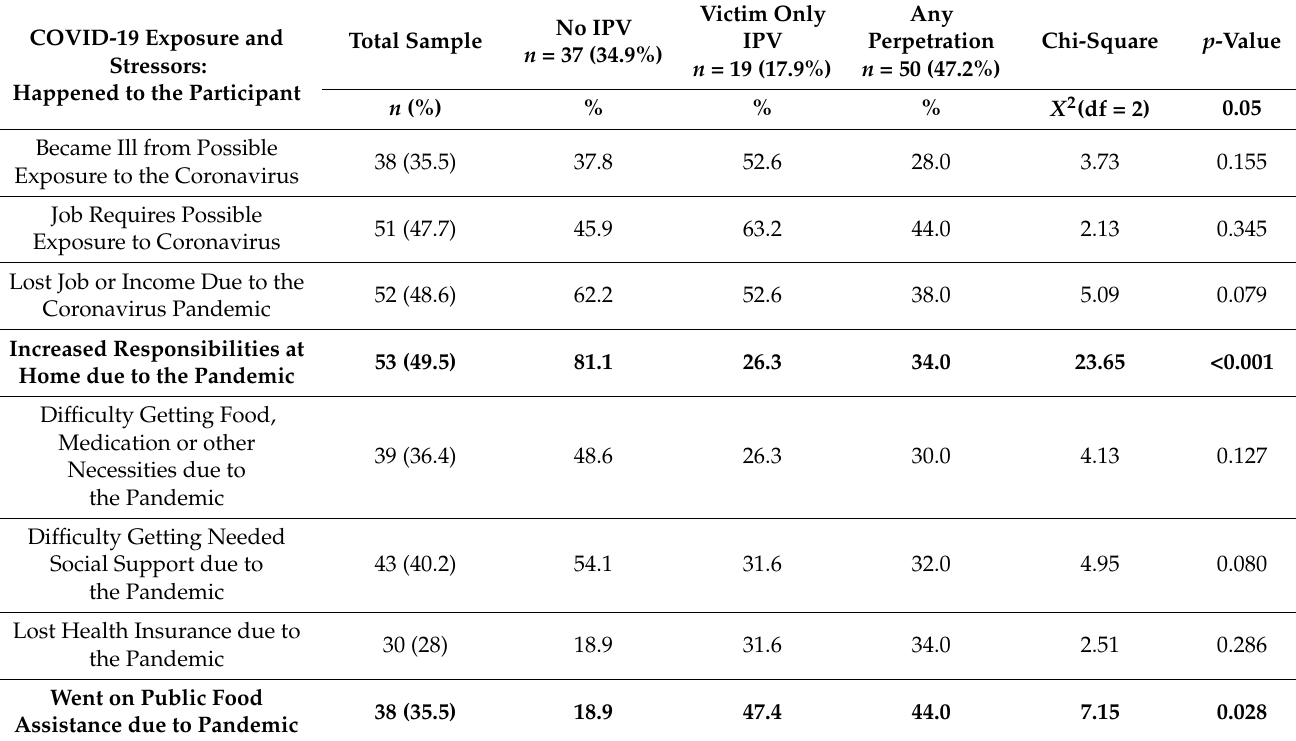
Table 4. Chi-square analyses of the three IPV groups and the Coronavirus Stressor